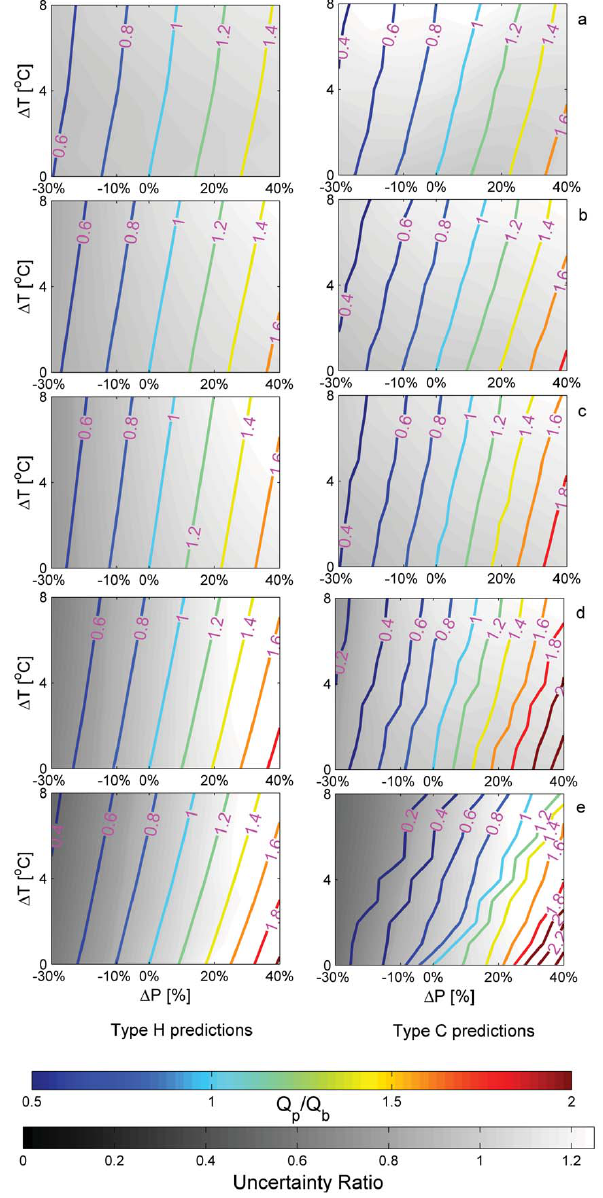
Fig. 4. . Contours of most probable streamflow (Q p ) in colored lines normalized by the most probable flow for the historical or base pe- riod (Q b ). The background grey variation shows the uncertainty in the predictions normalized with respect to the uncertainty predicted for historical flows for: (a) Lochsa, (b) Lower Androscoggin, (c) Escambia, (d) Meramec, (e) Yampa. Watersheds are arranged in order of increasing aridity